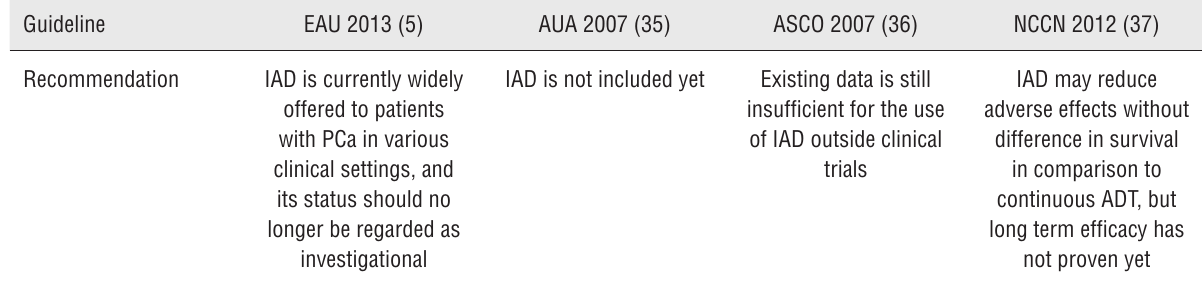
Table 3 - International guidelines for IAD.